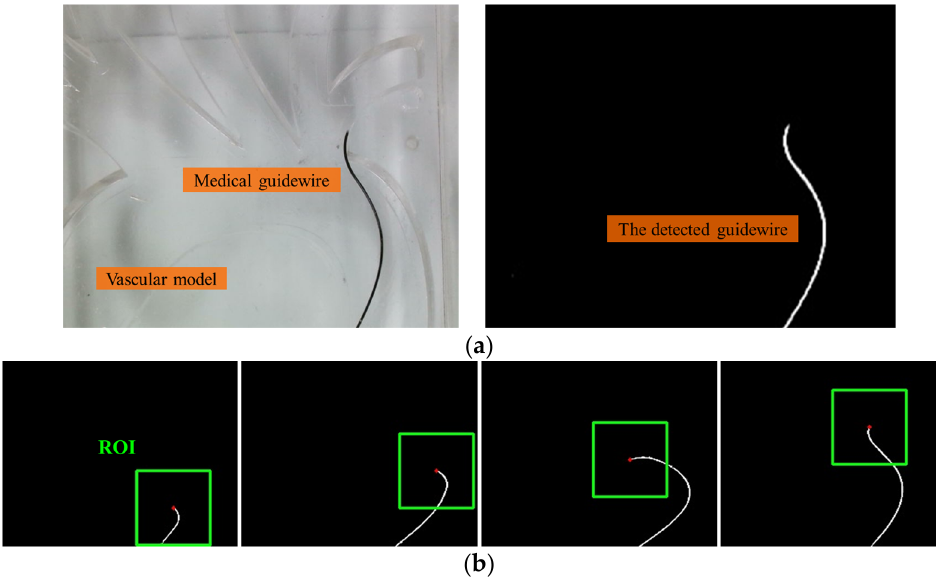
Figure 3. The image processing algorithm for the guidewire detection: ( a ) the captured guidewire within the vascular model based on the image processing algorithm; ( b ) the detected guidewire tip.